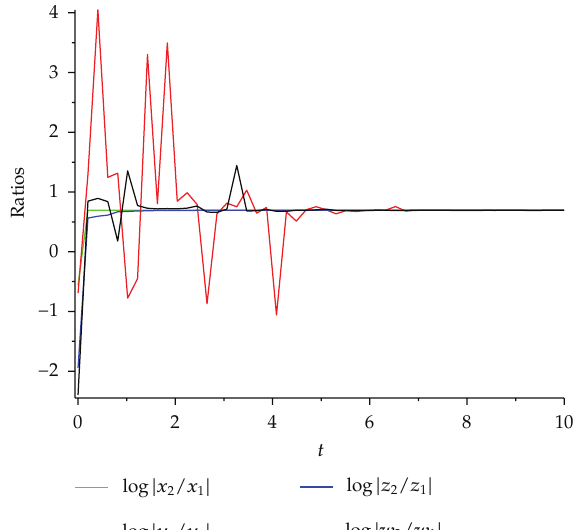
Figure 8: It shows the evaluation of the ratios log | x 2 /x 1 | , log | y 2 /y 1 | , log | z 2 /z 1 | , and log | w 2 /w 1 | whose limits are equal to log2 (cid:8) 0 . 693.